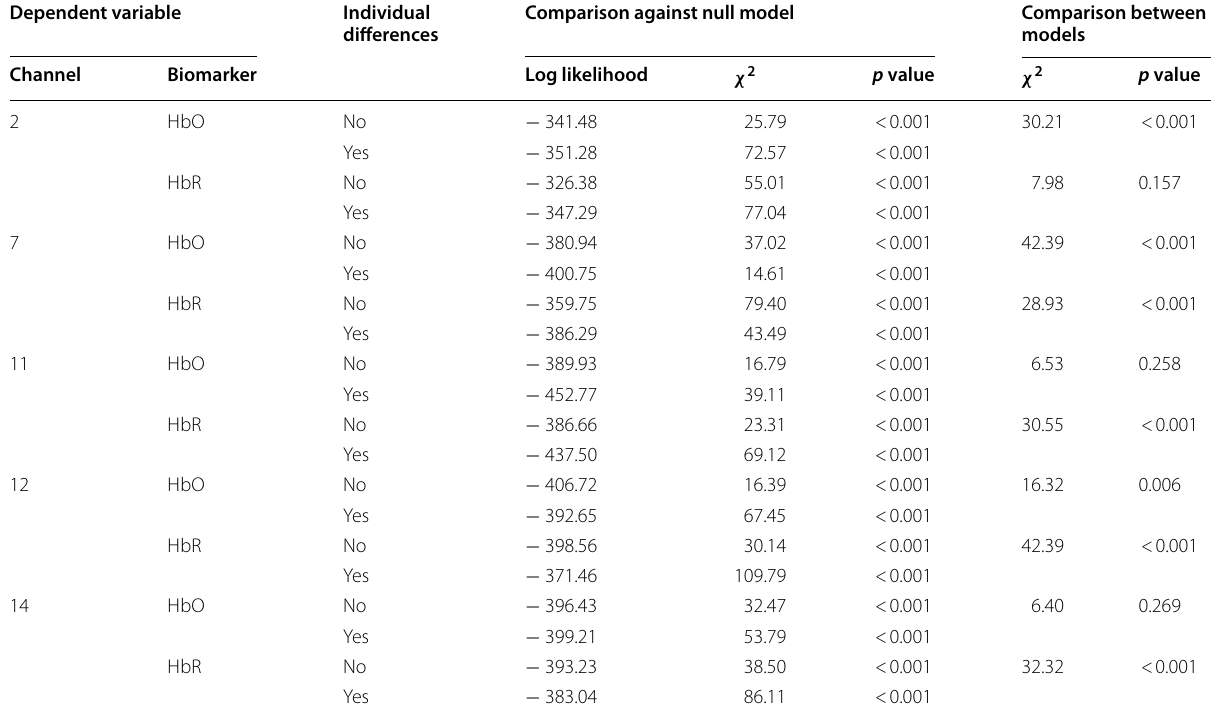
Table 2 Comparison of goodness of fit between models with and without group as fixed factor for mean fNIRS measures from a subset of